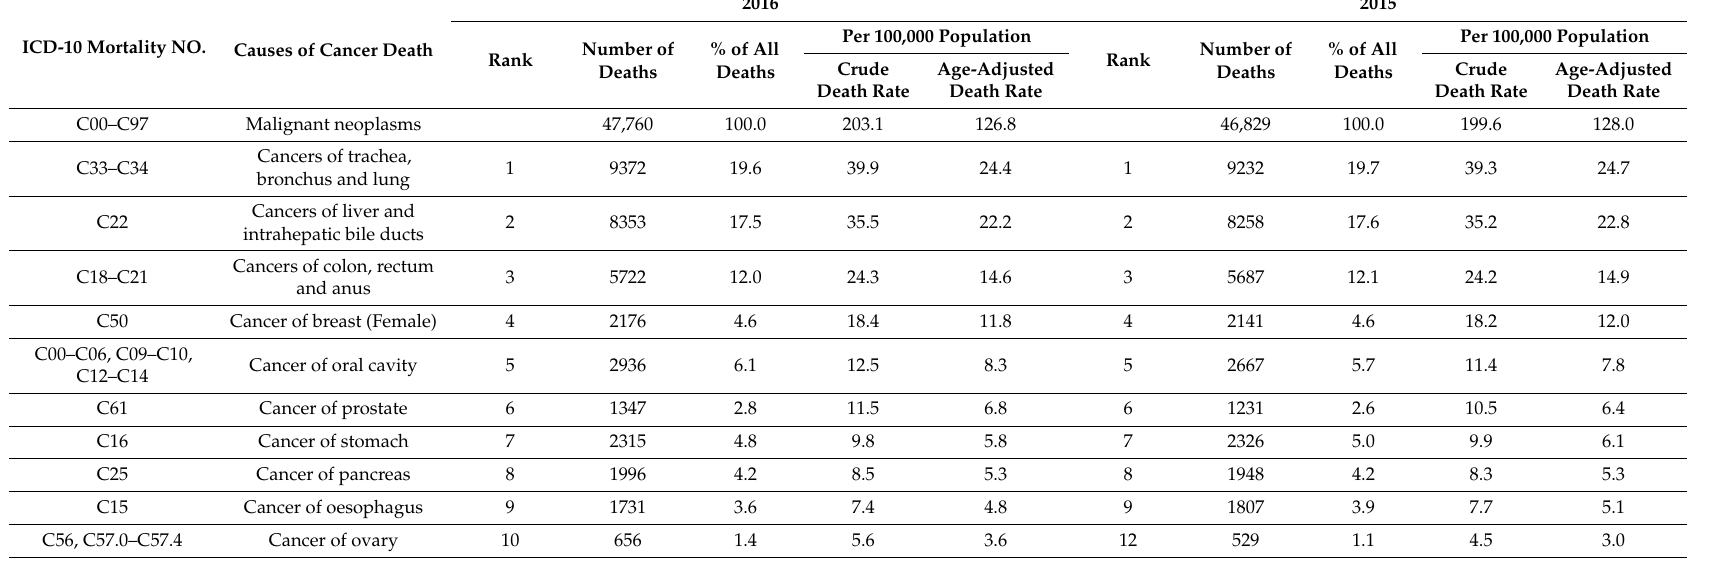
Table 1. Causes of cancer death, 2015 and 2016 (Unit: Persons,